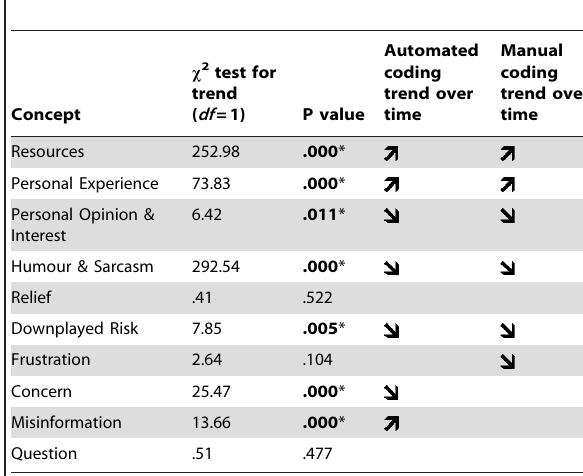
Table 7. Automated Coding Trends over Time.